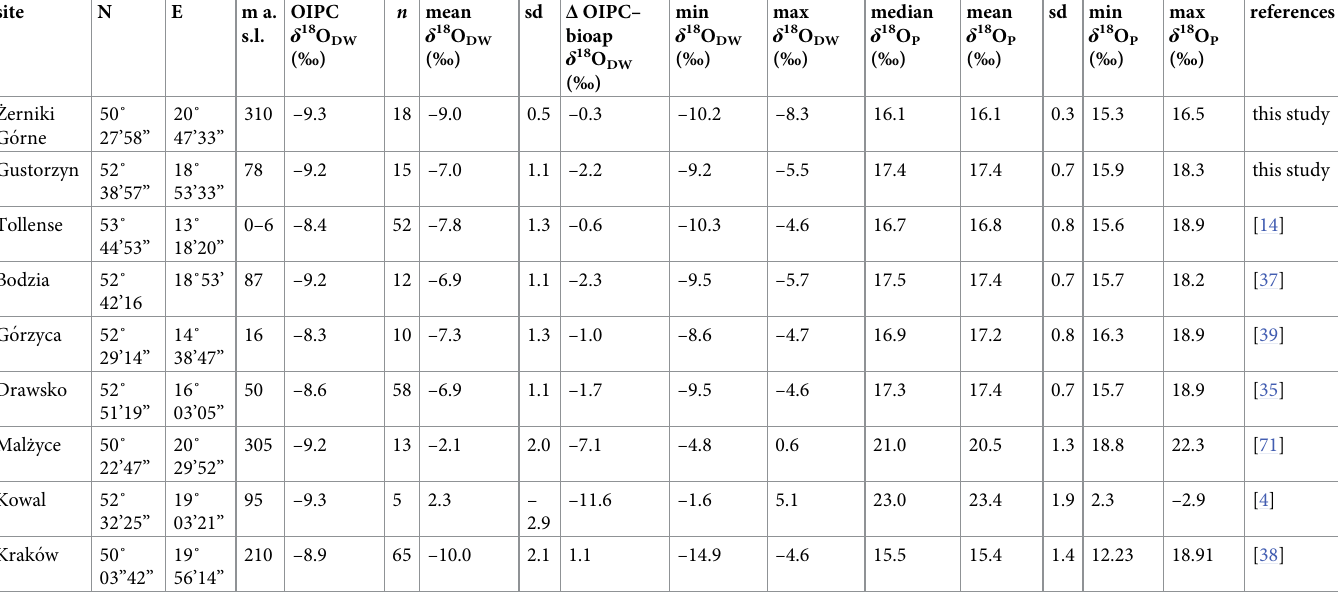
Table 3. Annual δ 18 O DW-VSMOW values estimated using Online Isotopes in Precipitation Calculator (OIPC [115]) and δ 18 O P-VSMOW ratios measured for skeletal tis- sues of humans from prehistoric and early historic sites in Poland and north-eastern Germany discussed in this study (reported as δ 18 O P-VSMOW or calculated